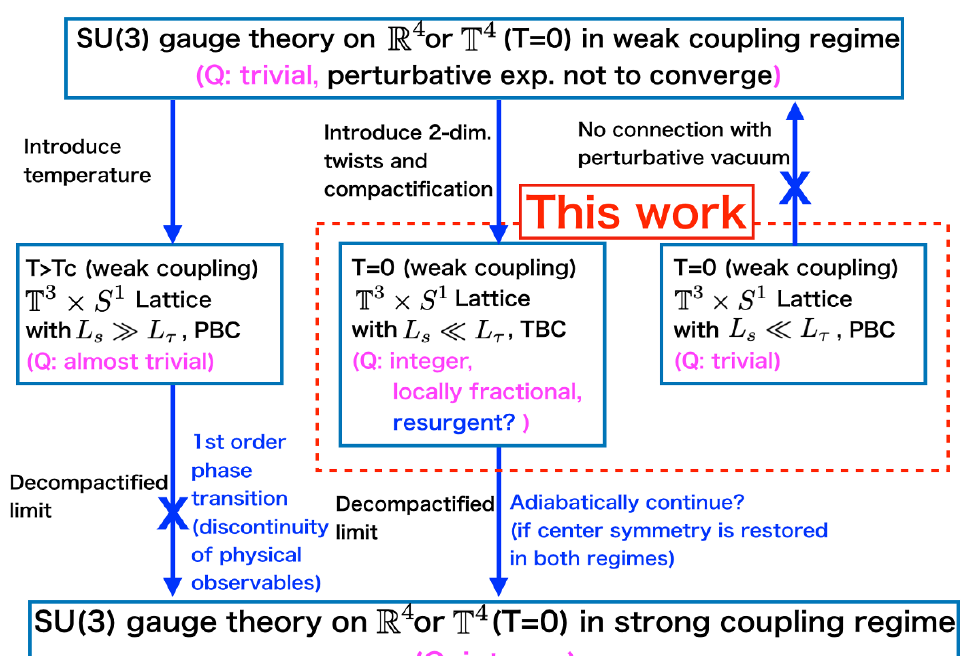
Figure 1 . Relationships among the SU(3) gauge theories on various spacetime structures and coupling regimes. The topological property ( Q ) for each setup is also shown. Cross symbols on the arrow denote that two theories does not connect with each other smoothly. In this work, we focus on two boxes located at the center and the